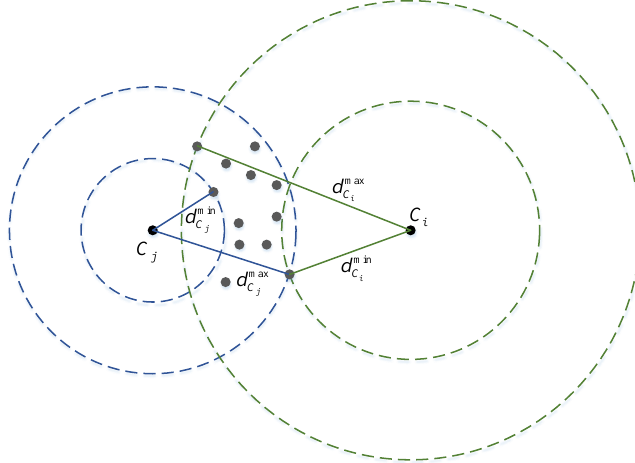
Figure 6. Scoring function for particles (gray dots) with two centers C i and C j . The maximum and minimum distances are used to scale the observation probability.